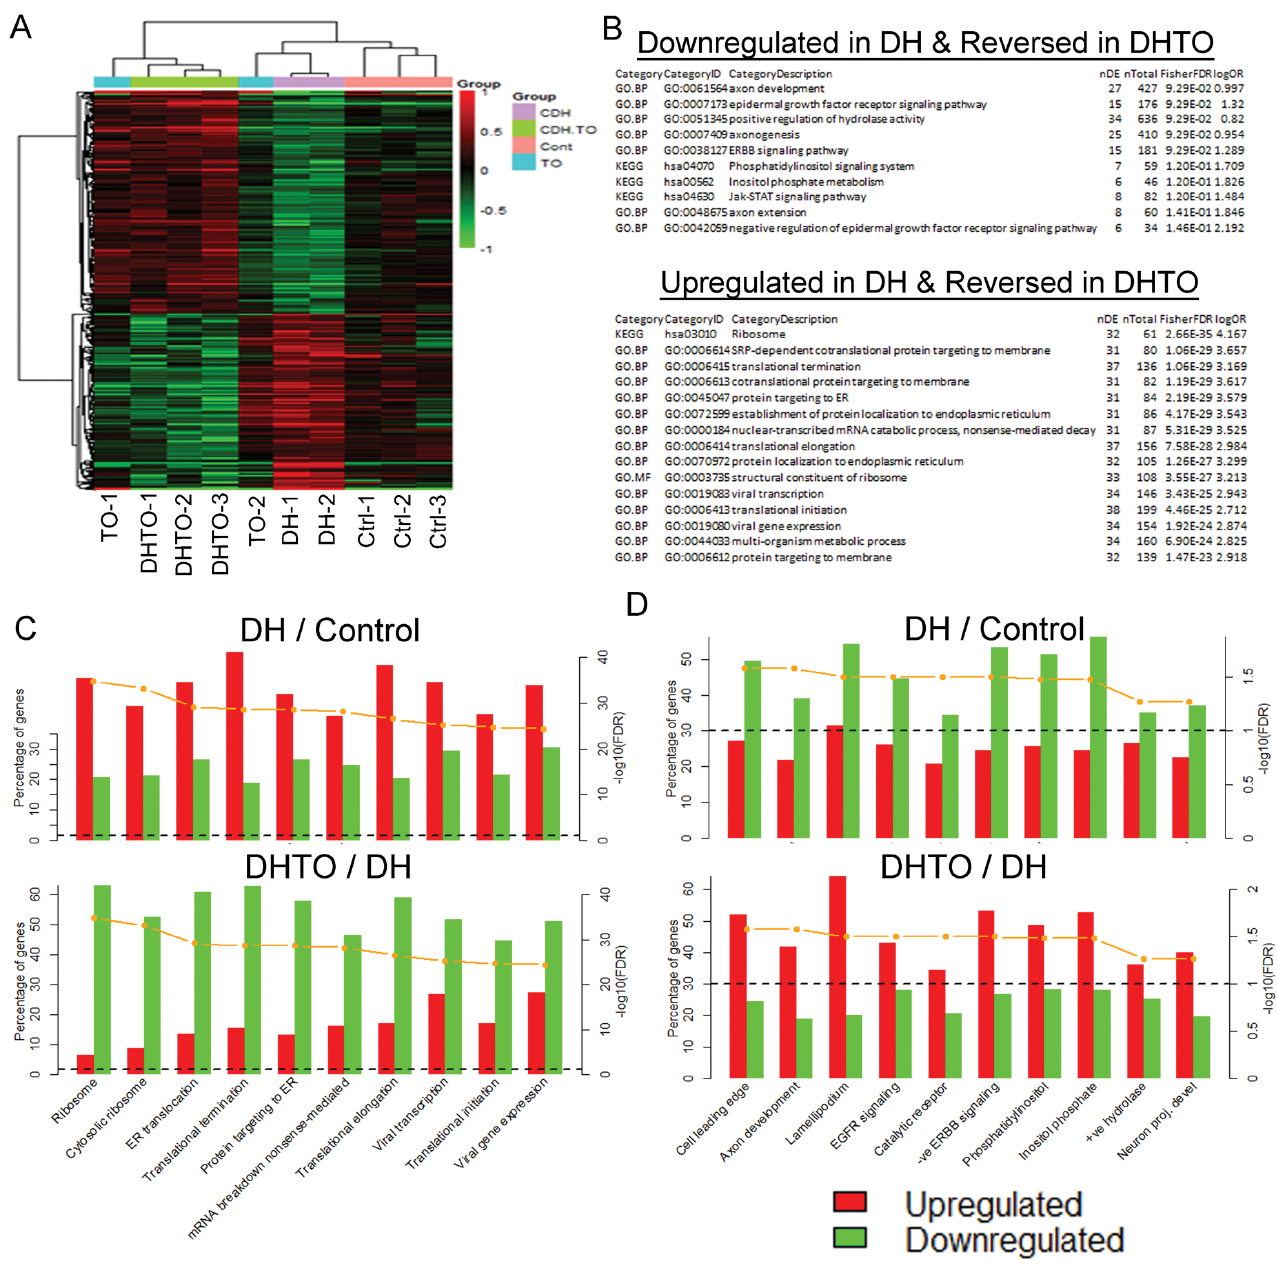
Figure 8. Reciprocal gene regulatory patterns in DH and DHTO. (A) Hierarchical clustering of genes increased in DHTO and decreased in DH yielded clusters similar to clustering using all genes except that in this analysis one TO sample was most similar to DHTO and one TO sample was most similar to DH. The expression of genes in the control group was generally between that of DHTO and DH. (B) Pathway analysis of genes downregulated in DH and upregulated in DHTO revealed that the top ten upregulated pathways and processes were all downstream of epidermal growth factor receptor or ephrin signaling. The top fifteen pathways downregulated in DH and upregu- lated in DHTO all involved protein synthesis or trafficking. (C) The ten most significantly altered processes downregulated in DHTO versus DH all involved protein synthesis or trafficking and had reciprocal upregulation in DH versus control. The dashed line represents statistical significance. (D) The top ten upregulated processes in DHTO versus DH also had reciprocal downregulation in DH versus control. Similar to the list of top regulated processes using differentially regulated genes in all groups, epidermal growth factor receptor and ephrin signaling (axon development) were represented, but two of the top three processes involved small GTPases (cell leading edge and